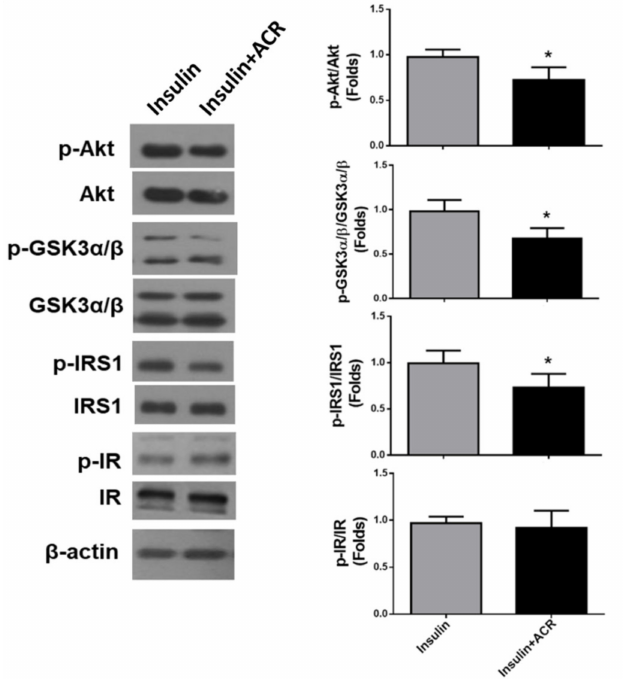
Figure 4. Acrolein interferes with insulin signaling in differentiated C2C12 myotubes. Myotubes were treated with 1 µ M acrolein for 24 h and then stimulated with insulin (10 nM) for 10 min. The levels of phosphorylated and total protein expression of Akt, GSK3 α / β , IRS1, and IR were determined by Western blotting and quantified using densitometric analysis. Results are represented as means ± SEM for at least four independent experiments. * p < 0.05 versus insulin